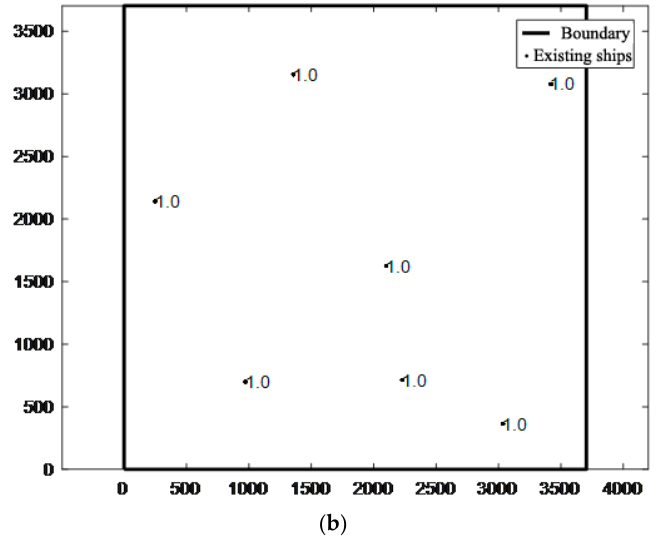
Figure 12. Schematic diagram of mooring area detection with wind force >7 and water depth of 40 m. ( a ) Represents 192 ‐ m and 192 m ship type mooring area detection. ( b ) Represents 333 m and 333 m ship type mooring area detection.